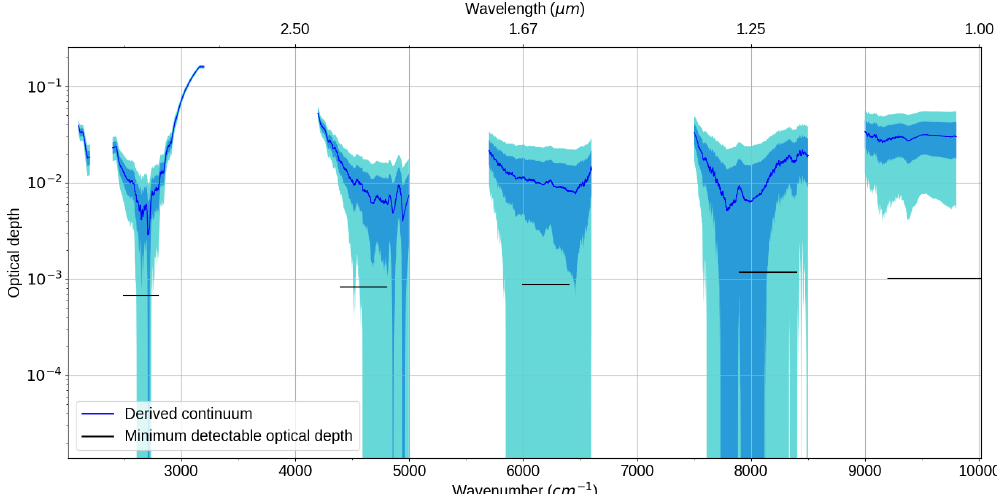
Figure 4. Minimum detectable optical depth in the various atmospheric windows presented in this work (horizontal black line) against derived continuum optical depth from 18 September 2008 (blue line). The shadings indicate the k = 1 (blue) and k = 2 (cyan) uncertainty